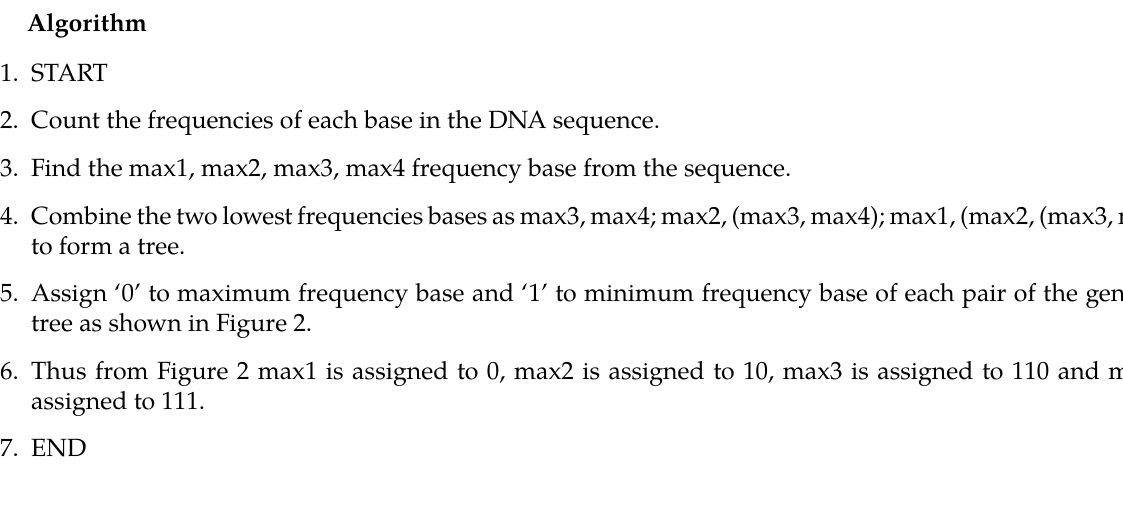
Figure 2: Generated extended binary